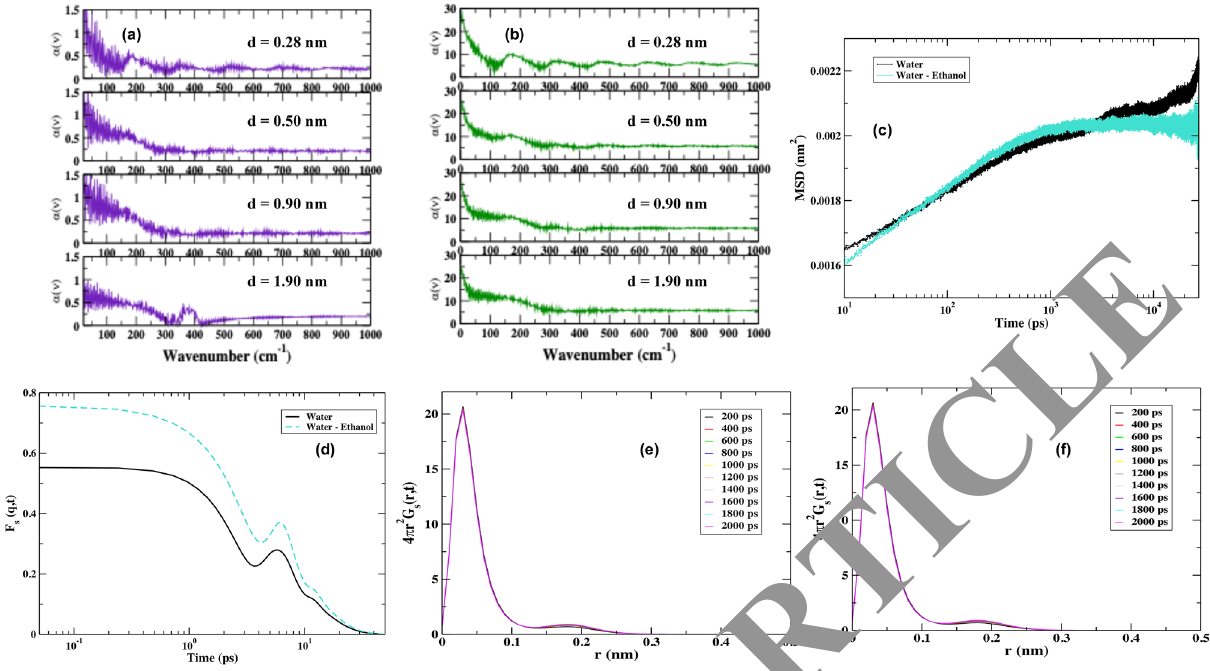
Figure 7. ( a ) The calculated distance-dependent absorption coefficient of water molecules in the hydration shell of the antibody in water and ( b ) in a water–ethanol solvent mixture. ( c ) The calculated MSD of the antibody in water (black) and in the water–ethanol mixed solvent (cyan) from MD simulation. ( d ) The short and intermediate time scale of the calculated self ISF of the antibody in water (black) and in the mixed solvent (cyan) from MD simulation. The van Hove self-correlation function of the antibody in ( e ) water and ( f ) in a water–ethanol mixed solvent from MD